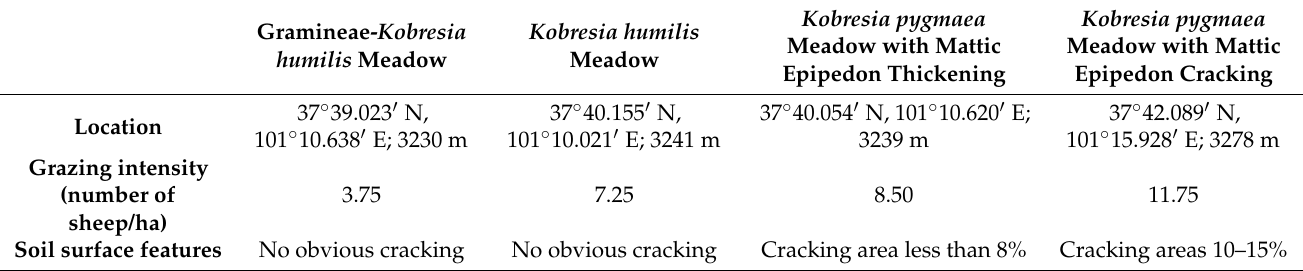
Table 1. General information about the sampling